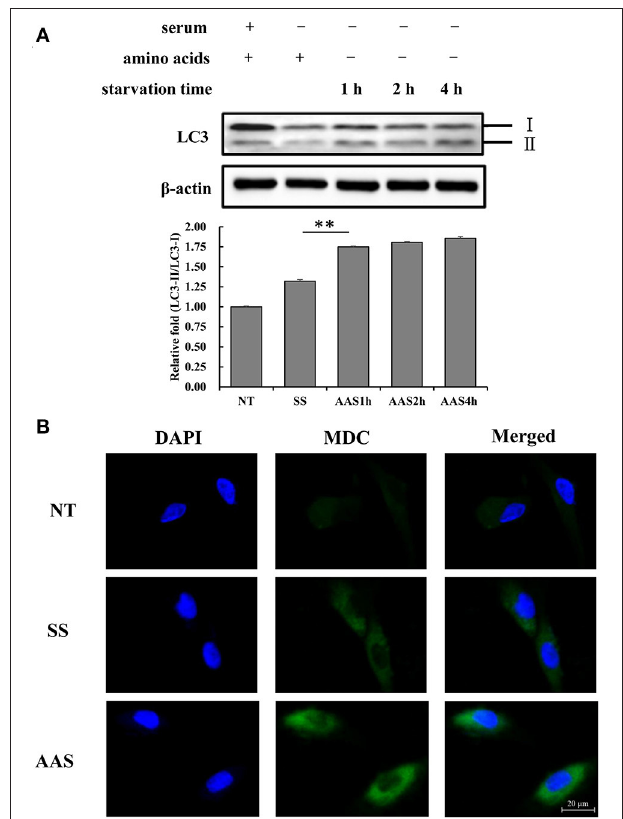
FIGURE 1 | Amino acid starvation induces cell autophagy in goat fetal fibroblasts. (A) The proteins were extracted from cells in non-treated condition (NT group), serum starvation medium for 16h (SS group), amino acid starvation medium for 1h after serum starvation (AAS1h group), amino